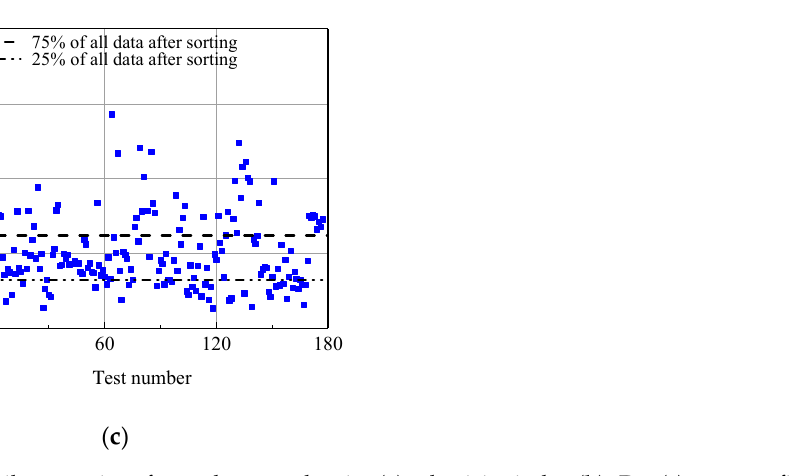
Figure 3. Erodibility parameters of the Wilson model: the erodibility parameters b 0 ( a ); the erodibil- ity parameters b 1 ( b ).